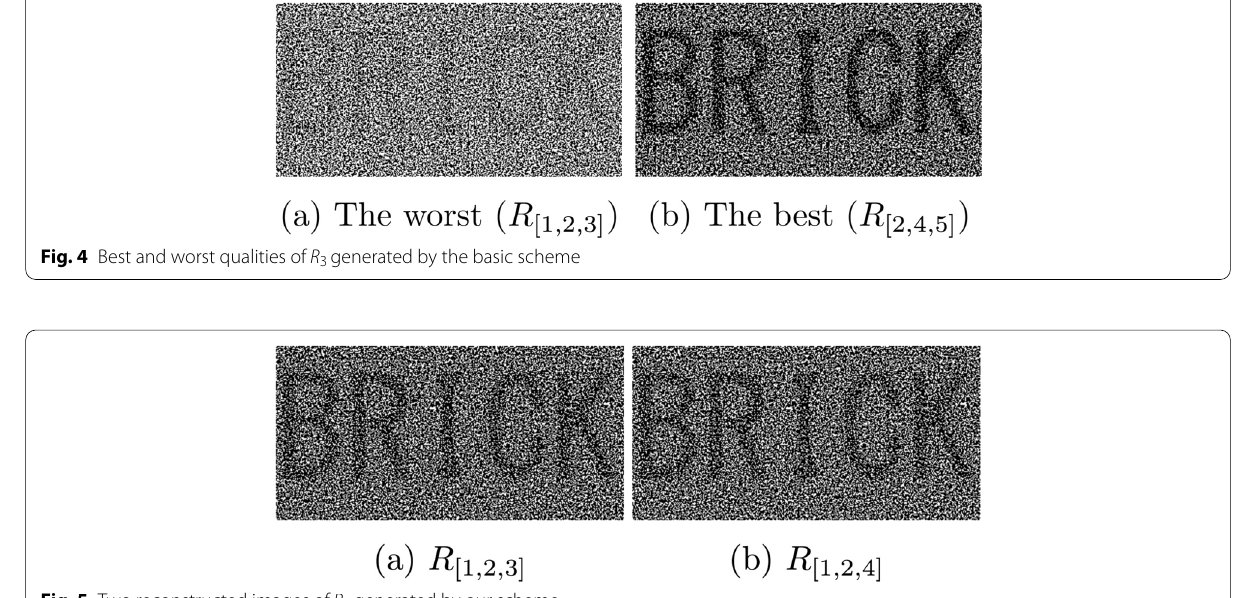
Fig. 5 Two reconstructed images of R 3 generated by our